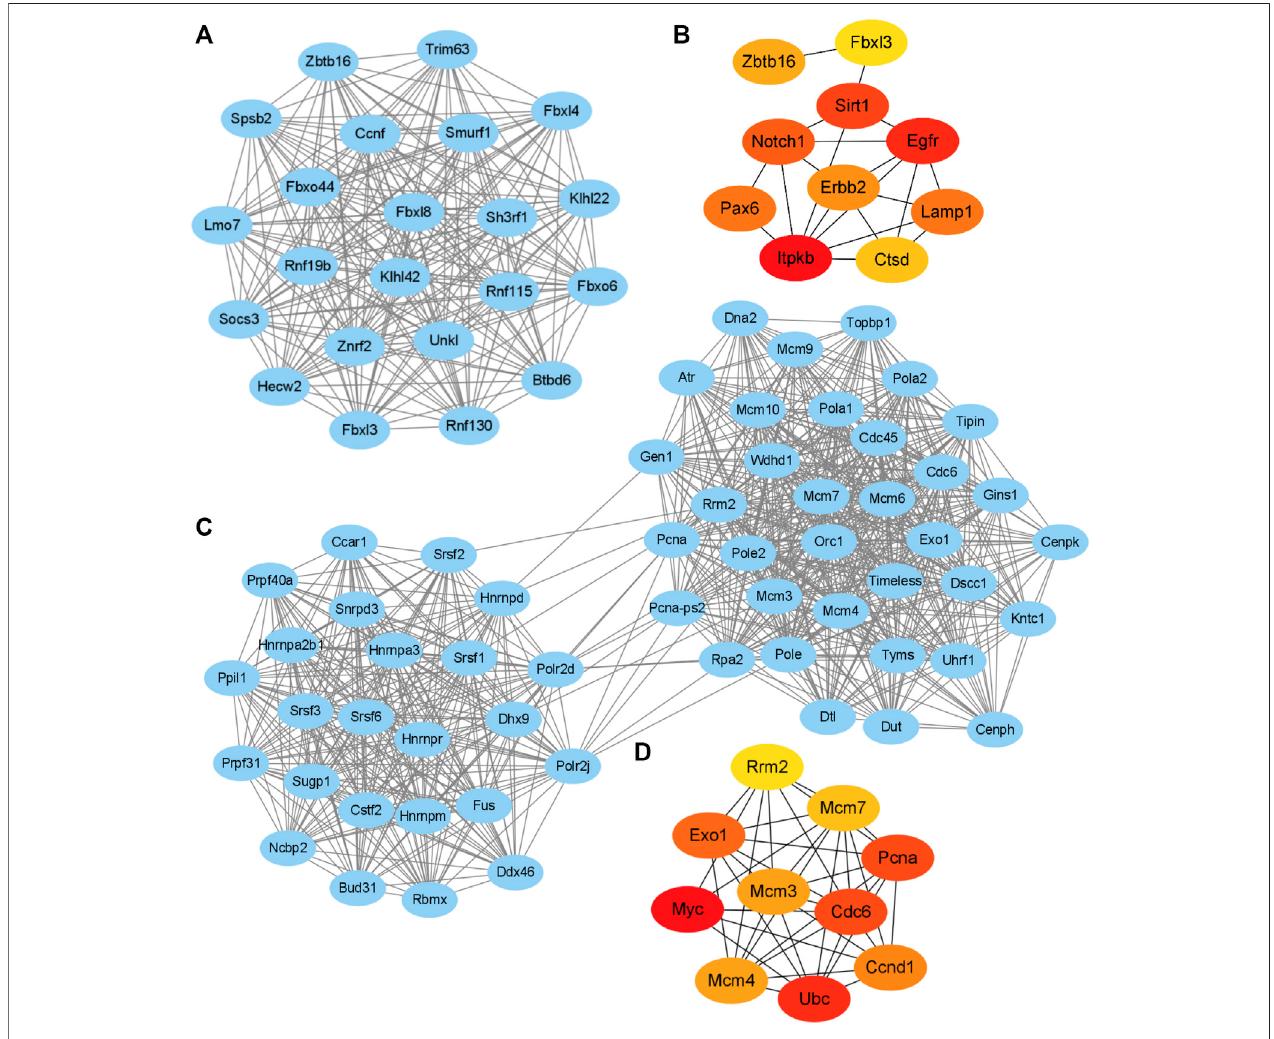
FIGURE 5 | Key modules and hub gene analysis of the DEGs. The PPI networks were constructed and the most signi fi cant modules of the upregulated DEGs (A) and downregulatedDEGs (C) wereobtainedusing MCODEapp from Cytoscape. Thetop10hubgenesoftheupregulated (B) and downregulatedDEGs (D) according tonodedegreewereachievedusingcytoHubbaappfromCytoscape,respectively.Thedarkercolorofthedotindicateshigherscoreandhigherimportanceofthegene.